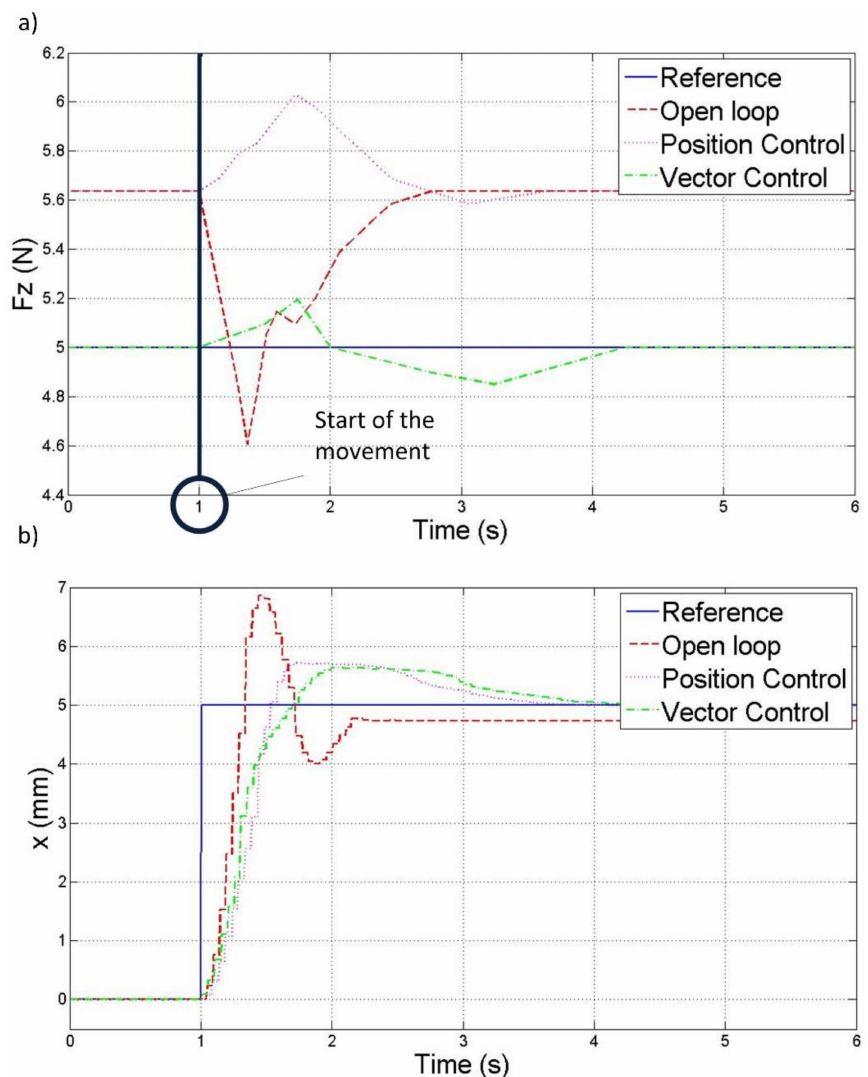
Figure 10. Experimental result: Variation of vertical force ( a ) and position ( b ) during movement of